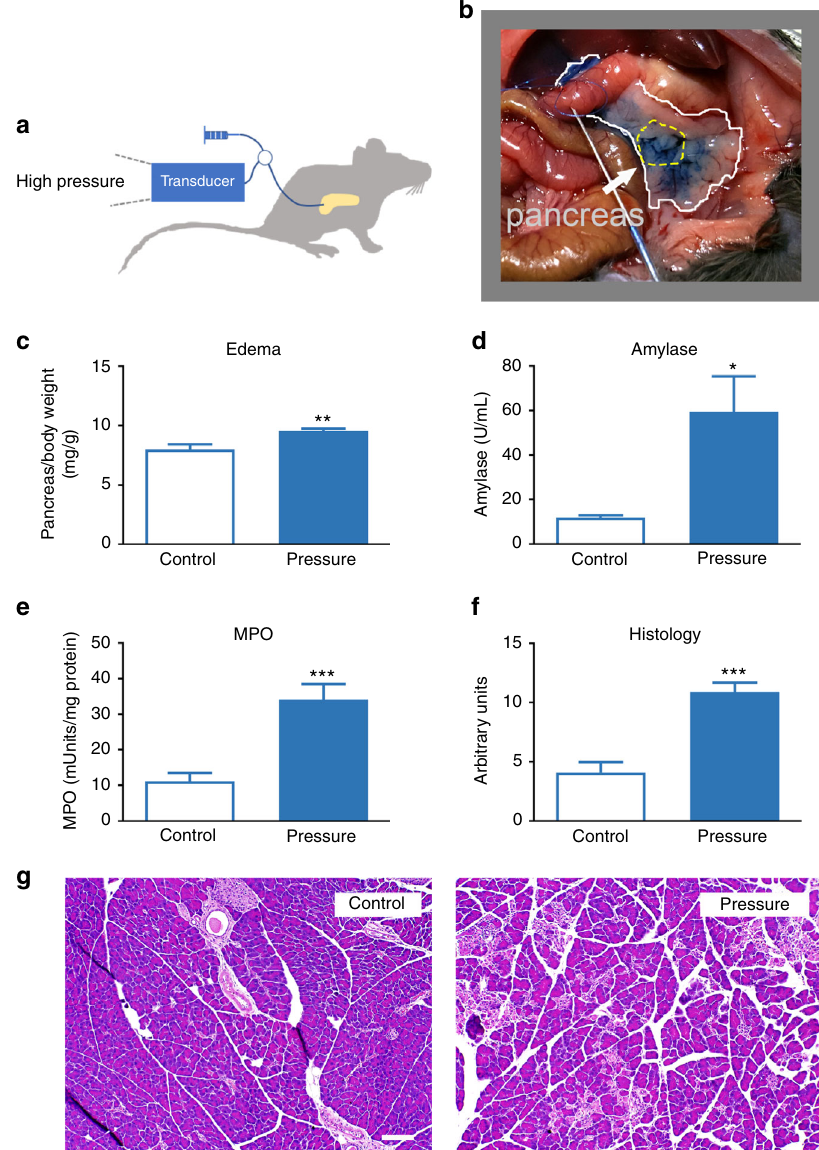
Fig. 1 Intrapancreatic duct pressure causes acute pancreatitis. a Test solutions were infused into the pancreatic duct of mice as illustrated. Injection pressures were continuously monitored using a pressure transducer. b Injection of 400 µ L buffered saline containing methylene blue dye was distributed throughout the pancreas. The white line indicates the boundary of the pancreas and yellow line indicates the mid-region of the pancreas that was used for histology and myeloperoxidase (MPO) determinations. Either sham-operated animals (control) or buffered saline solutions were infused at 25 – 33 mm Hg (pressure) and c edema, d blood amylase, e MPO, and f histological scoring were analyzed 24 h after duct injection in C57BL/6J male mice. Statistical analysis was performed using Student ’ s t test. * P ≤ 0.05; ** P ≤ 0.01; *** P ≤ 0.001 ( n = 7 – 13 for control and 13 – 17 for pressure). g Representative images of pancreatic tissue stained with H&E. Bar = 100 µ